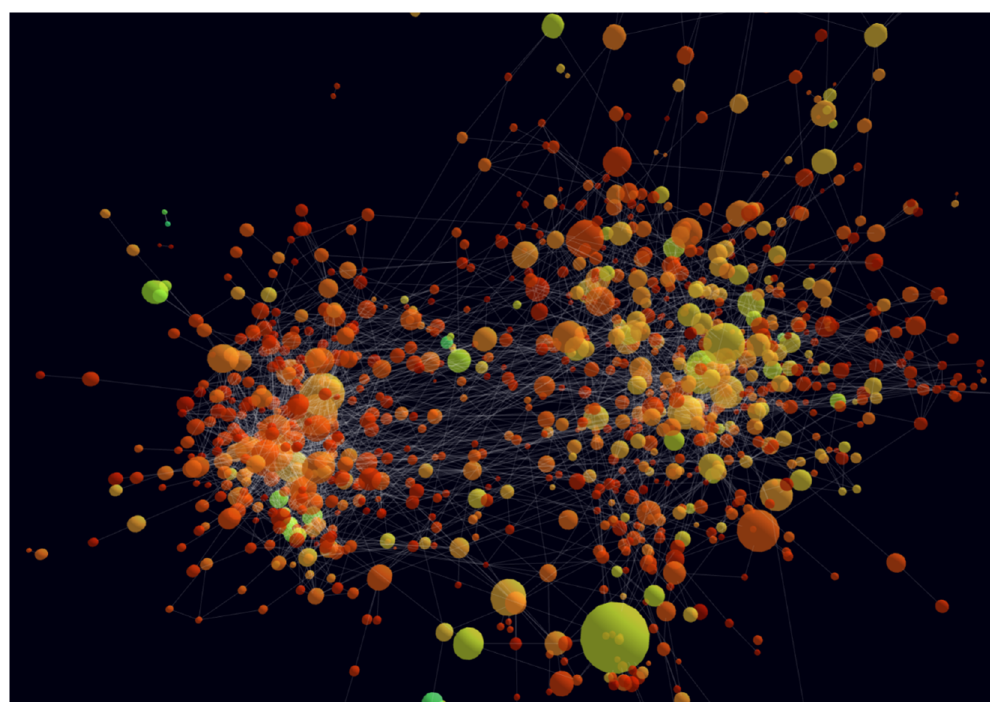
Figure 1. Three-dimensional citation graph of the exemplary dataset.